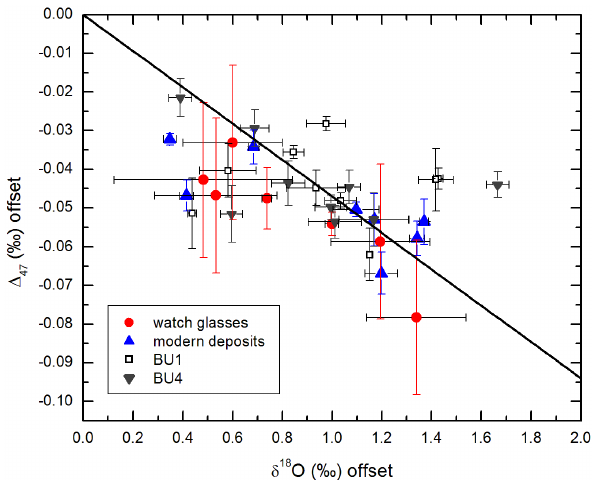
Fig. 3. Sensitivity analysis of the drip-water δ 18 O w values (calcu- lated via the co-variation method) on the co-variation slope. The reference point is a slope of − 0.047 (arrow on the bottom) and a drip-water value of − 7.9‰, as observed for the modern deposits and the drip water of Bunker Cave. The dotted horizontal lines in- dicate a ± 0.3 ‰ uncertainty range in the drip water around this reference value. The thick line refers to a sample that is 1‰ offset in calcite δ 18 O c from equilibrium. Lower (dashed line) and higher offsets (short dashed line) are also given for comparison. The inset shows the details around the reference slope